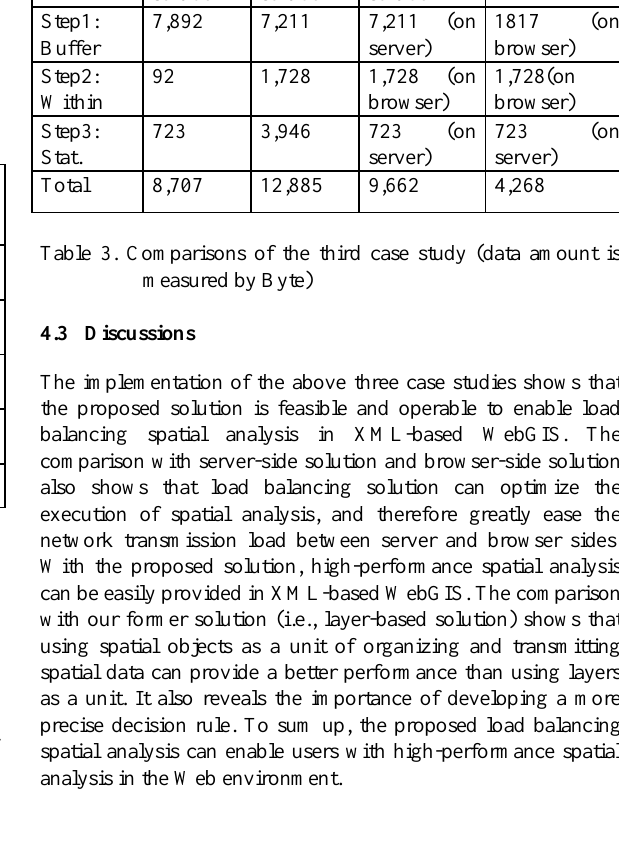
Figure 5. Listing the length of railways in each of the administrative districts they pass through